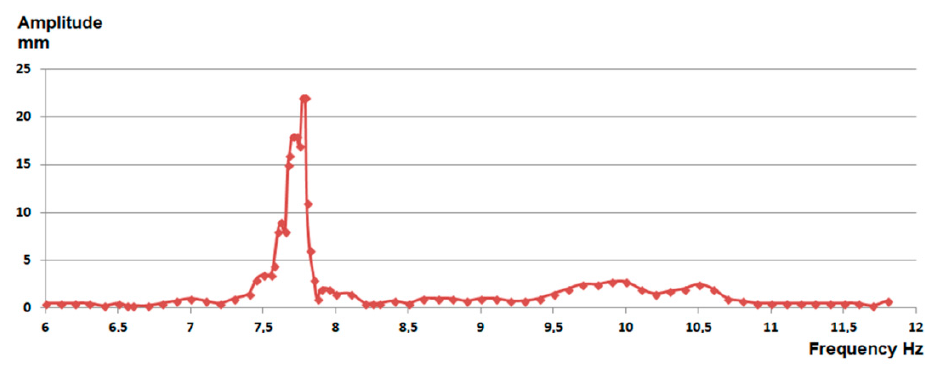
Figure 11. Amplitude spectrum of trolley wires horizontal placement.